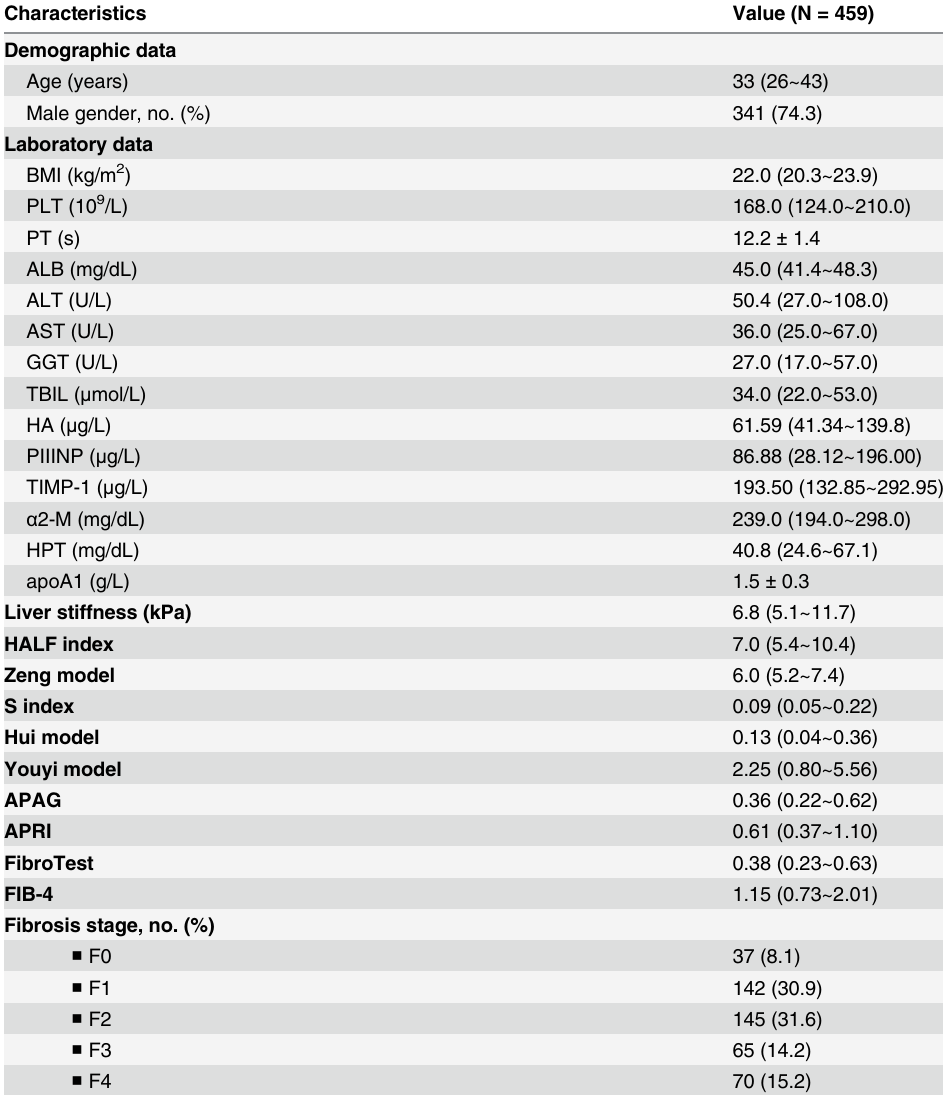
Table 2. Characteristics of the 459 Patients.